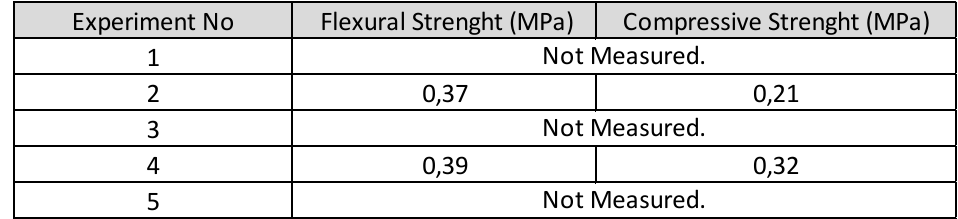
Table 9 The Results of Mechanical Property